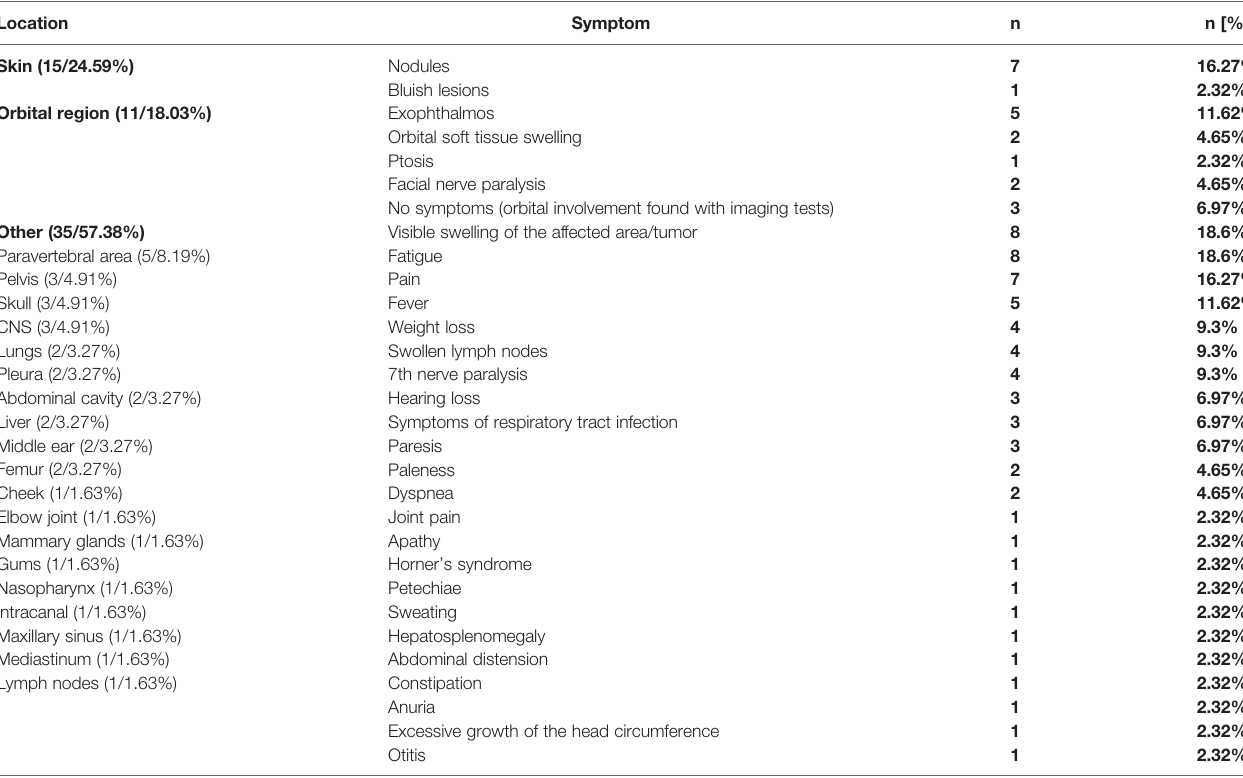
TABLE 1 | Location of all MS sites in the study group and symptom characteristics. Location Symptom Skin